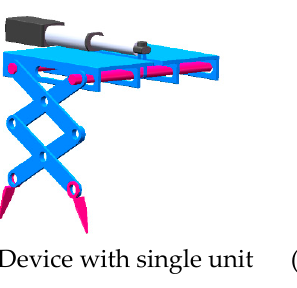
Figure 2. Stretchable unit and overall assembly.